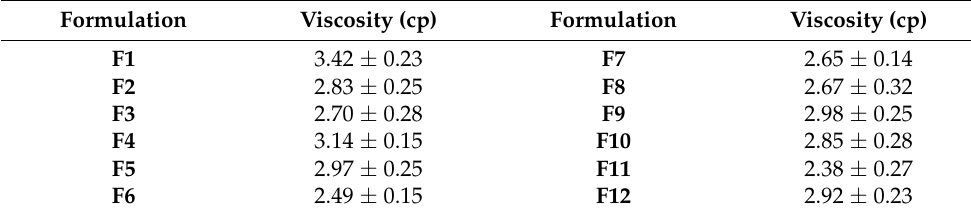
Table 3. Characterization of different DPE-NE